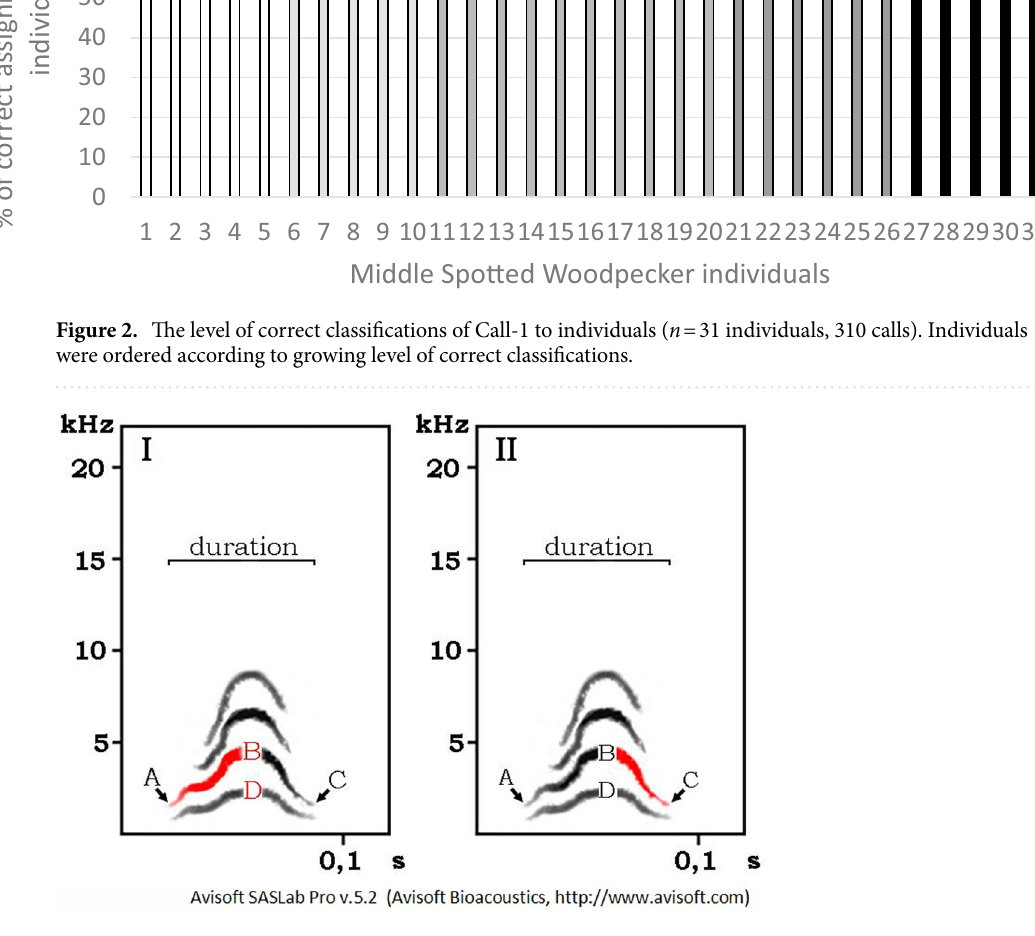
Figure 3. Sonograms of Call-1 with acoustic parameters (marked in red) that explained the highest level of: I. between individual variability (B—frequency of the mid-part of the dominant frequency, A/B—the change in the frequency of the first partof the dominant frequency, D—frequency of the mid-part of the fundamental frequency) II. between-sex variability (C/B—the change in thefrequency of the second part of the dominant